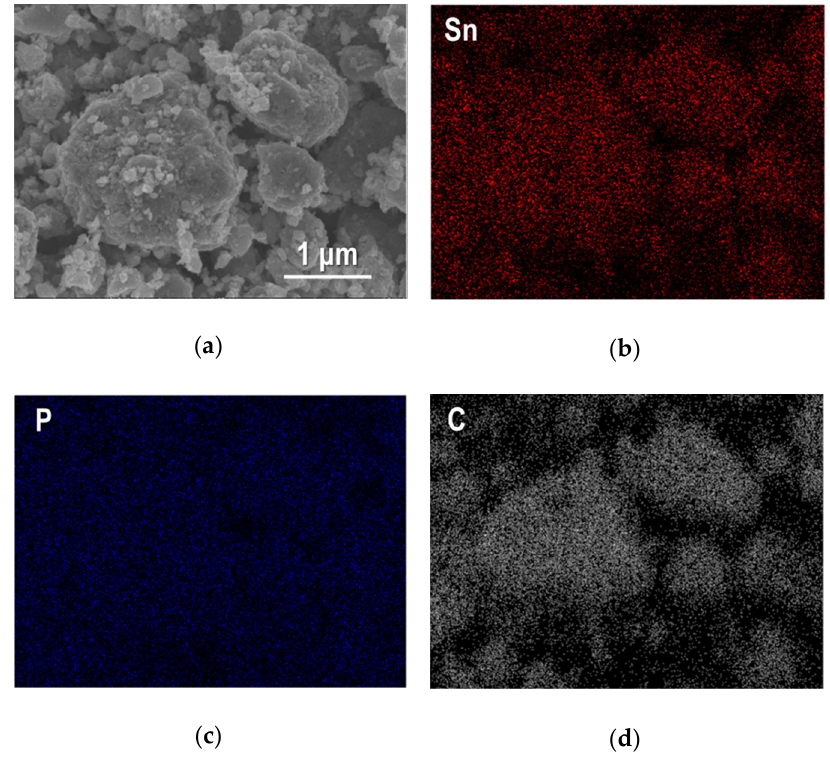
Figure 3. ( a ) SEM image of Sn 4 P 3 /C composite powder and corresponding element mapping for Sn, P and C are shown in ( b ), ( c ) and ( d ).